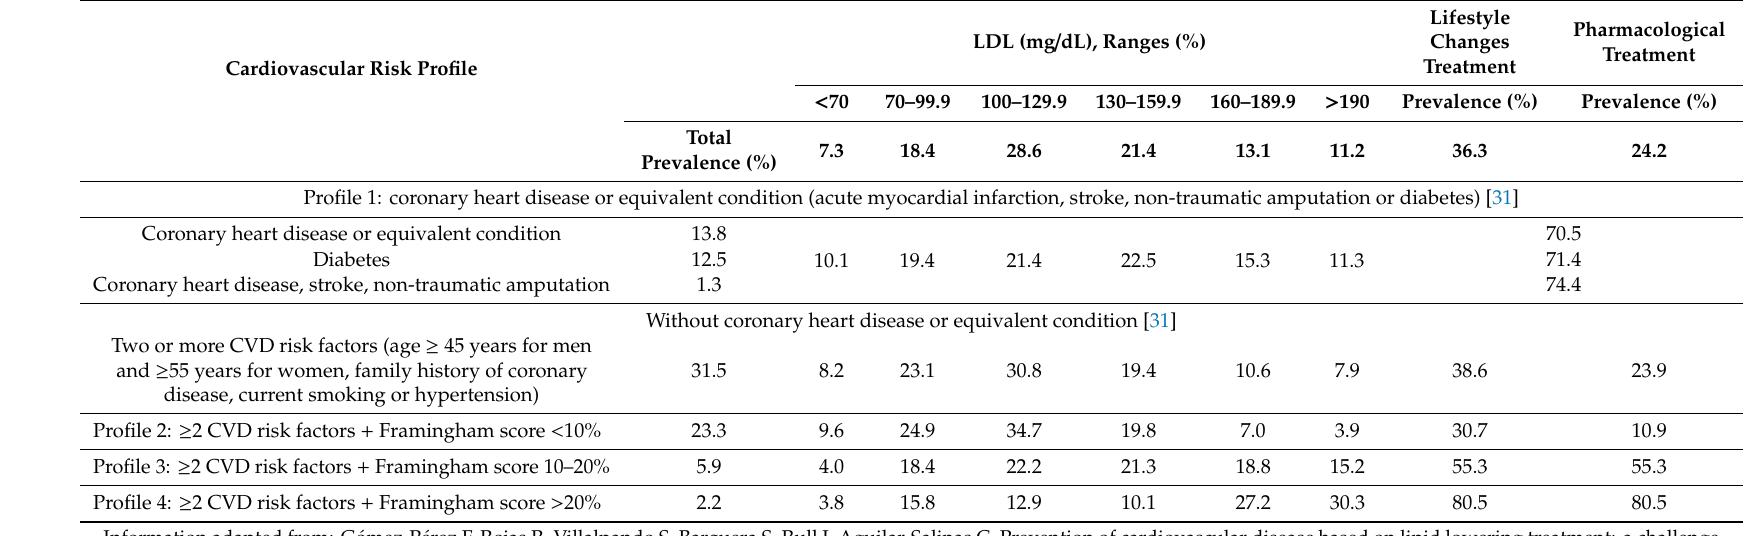
Table 3. Prevalence of Mexican adult candidates for treatments according to cardiovascular risk profiles,